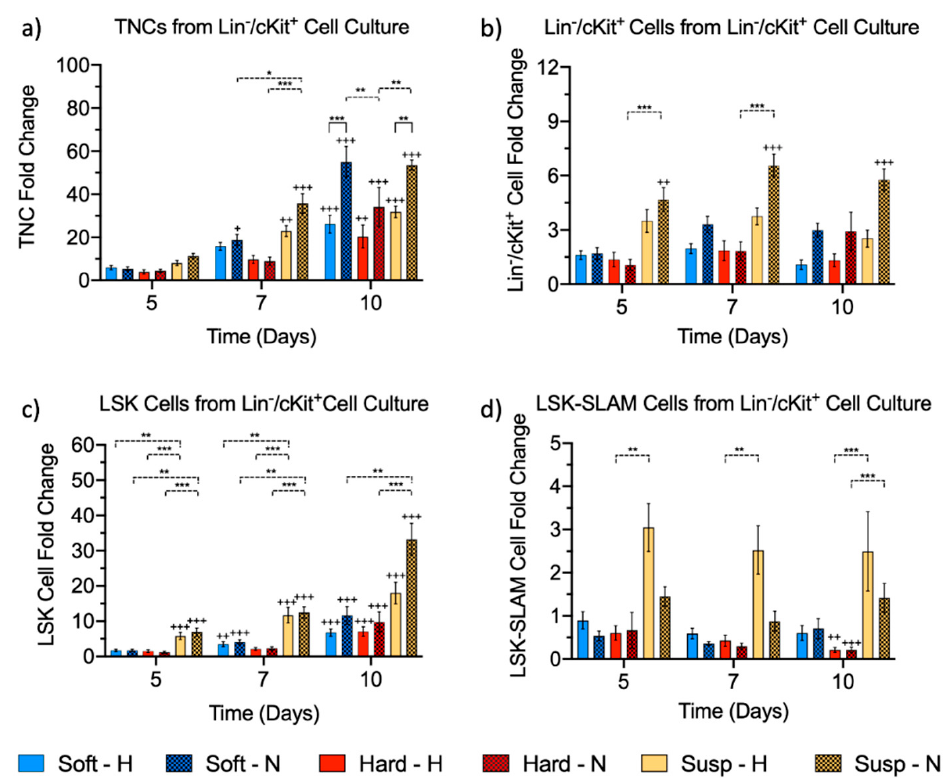
Figure 2. Quantification of total nucleated cells (TNCs) by NucleoCounter ® and hematopoietic stem / progenitor cell (HSPC) subgroups by flow cytometry retrieved from hydrogels (soft and hard) and suspension cultures (Susp) under hypoxia (H) and normoxia (N) relative to initial cell number over a culturing period of 10 days, shown as fold change of ( a ) TNCs, ( b ) Lin − / cKit + cells, ( c ) Lin − / Sca + / cKit + (LSK) cells, and ( d ) LSK-Signaling Lymphocyte Activated Molecule (SLAM) cells: data were obtained from 6 biological replicates in 3 independent experiments except for suspension cultures in hypoxia, which contained 4 biological replicates. Data are presented as mean ± S.E.M. Statistical analysis was performed with a three-way ANOVA followed by Tukey post hoc tests for multiple comparisons. Asterisks denote significance between the di ff erent culture conditions (soft hydrogels, hard hydrogels, and suspension culture) or between hypoxia and normoxia: * p < 0.05, ** p < 0.01, and *** p < 0.001. The plus signs denote significance between data collected at di ff erent time points against day 0: + p < 0.05, ++ p < 0.01, and +++ p <